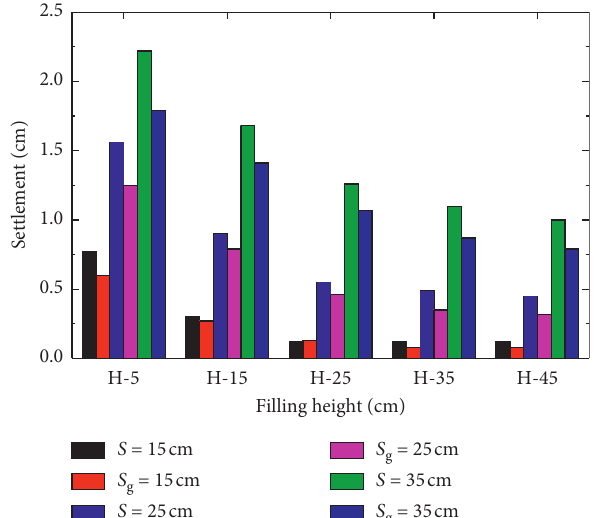
Figure 12: Comparison of the settlement between unreinforced and reinforced